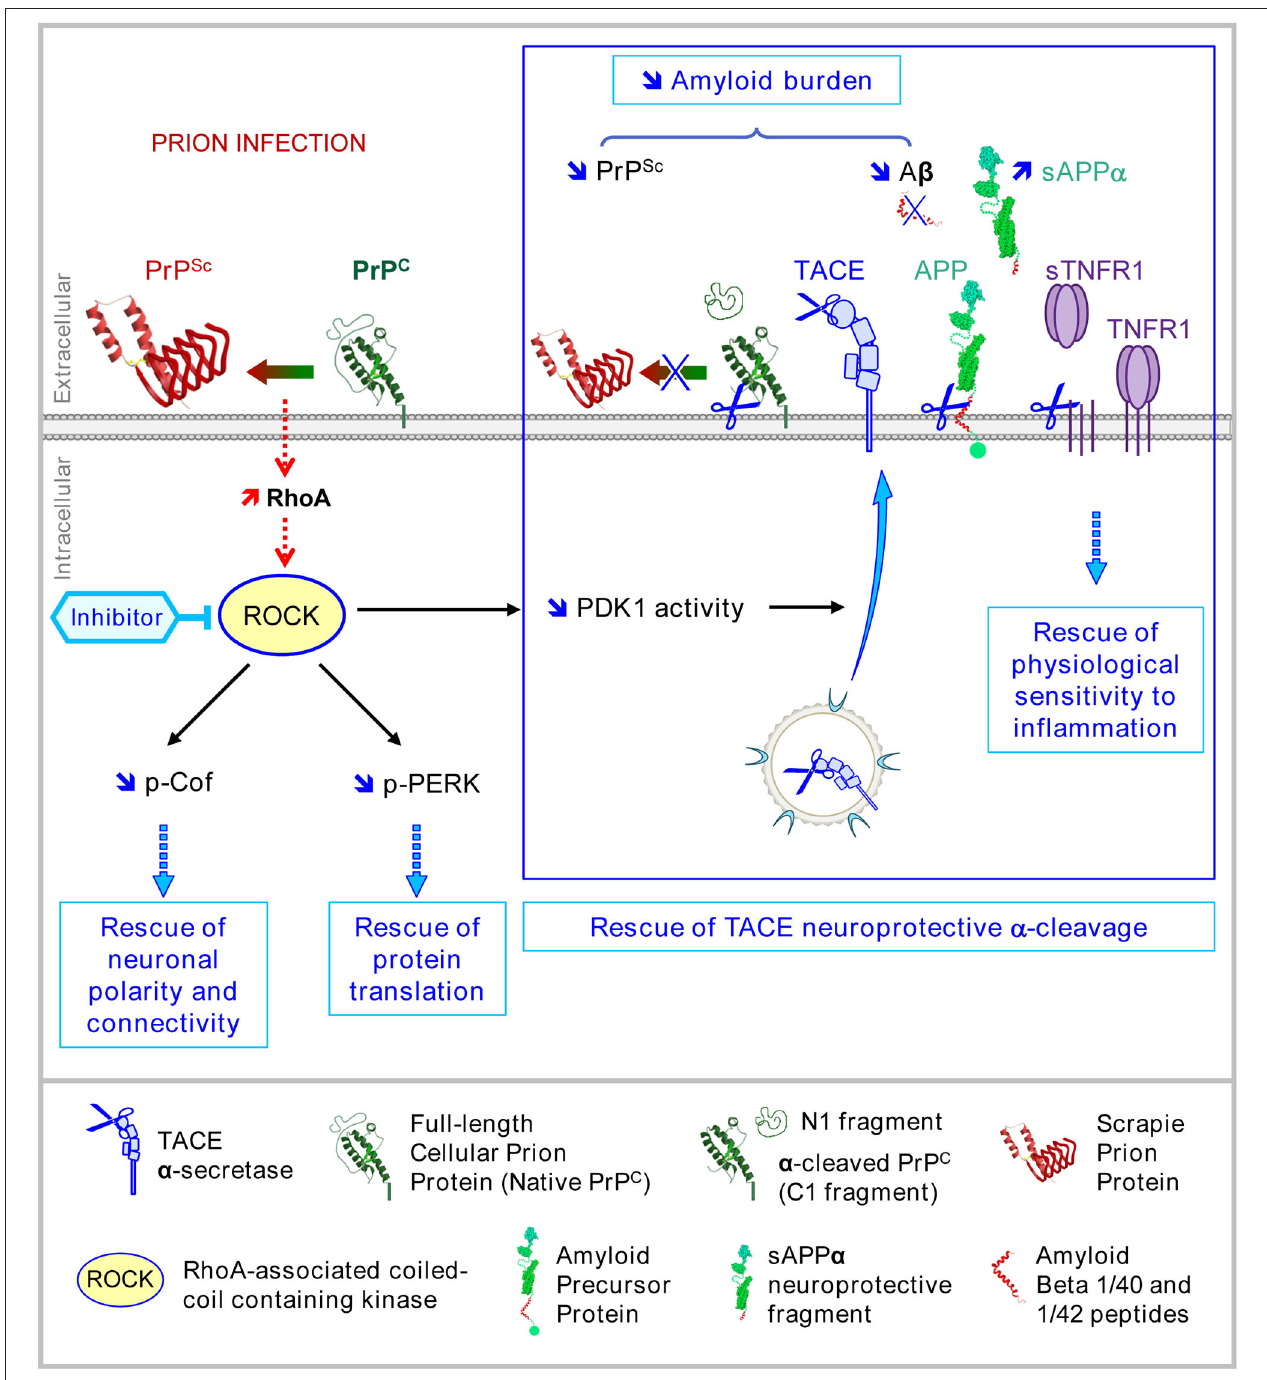
FIGURE 4 | Multiple beneficial effects afforded by ROCK inhibition in prion diseases. In prion diseases, the pharmacological inhibition of ROCKs with Y-27632 or dimethylfasudil counteracts PrP Sc neurotoxicity by rescuing (i) the neuronal polarity and connectivity through the restoration of cofilin-mediated actin severing, (ii) eIF2 α -dependent protein translation through attenuation of PERK signaling, and (iii) the neuroprotective TACE α -secretase activity toward three main substrates: TNFR1, which restores physiological sensitivity to TNF α , PrP C , and APP, which limits the accumulation of neurotoxic amyloids, i.e., PrP Sc and A β .